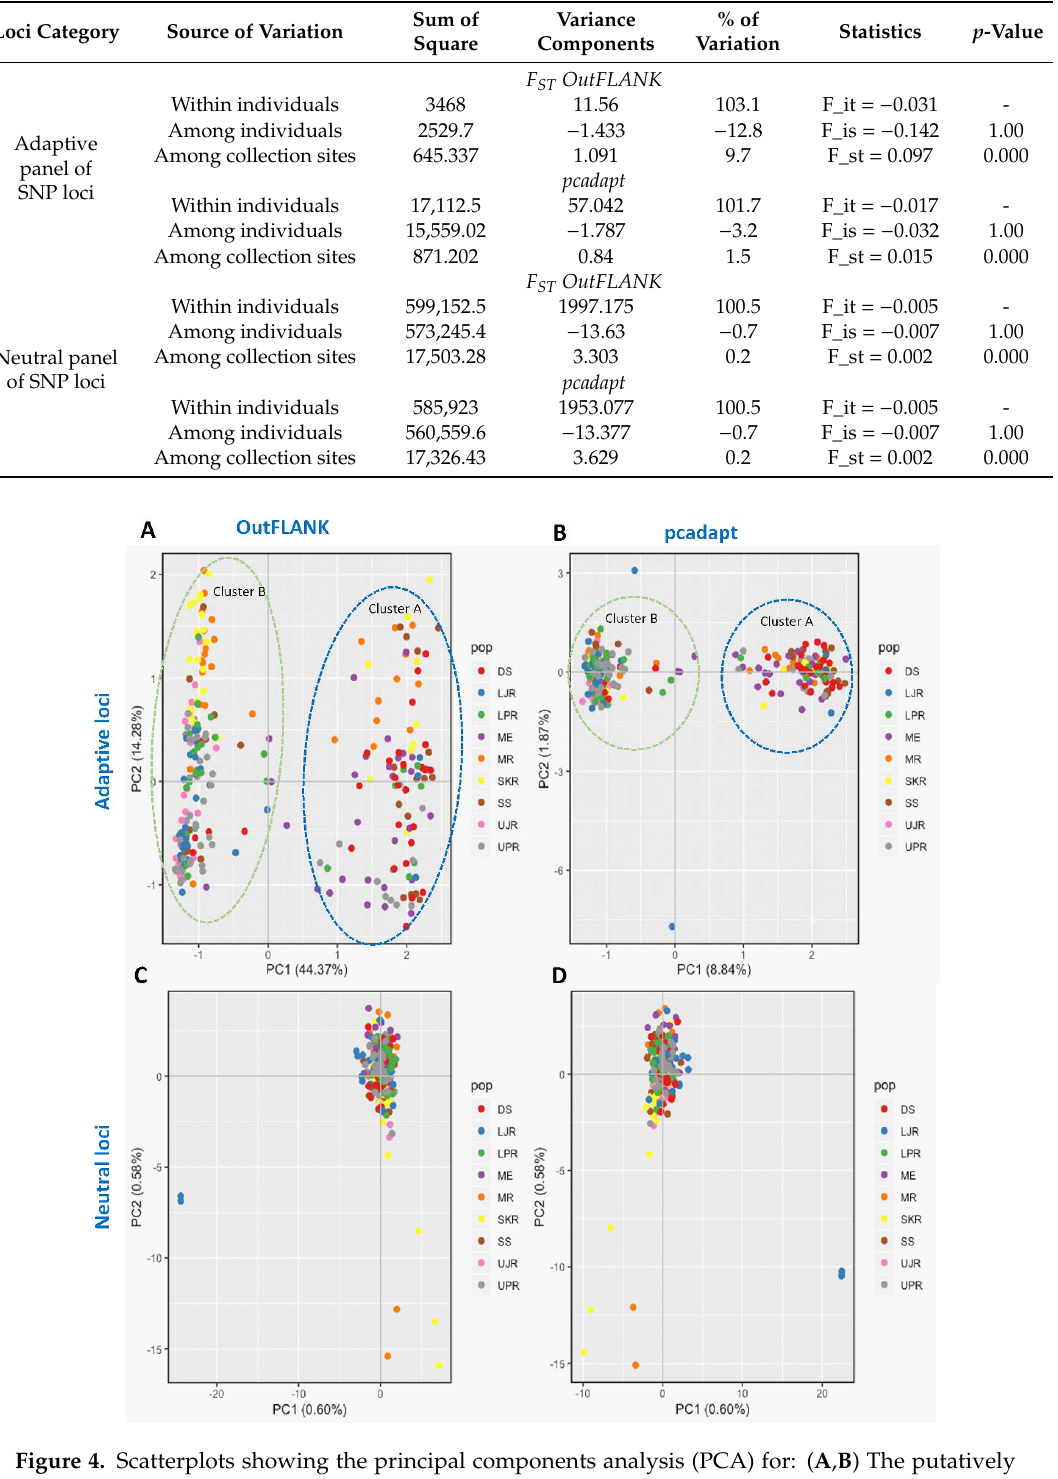
Table 3. Molecular analysis of variance for the putatively neutral and adaptive panel of SNP loci within and among the di ff erent collection sites of T. ilisha identified by the F ST OutFLANK and pcadapt approaches.